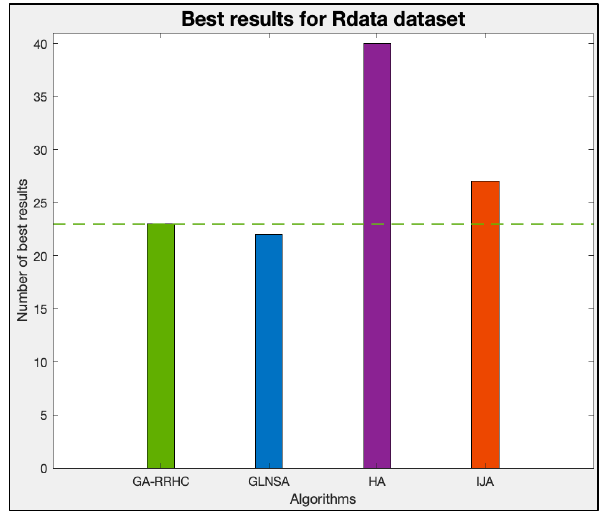
Figure 16. Number of best results per algorithm for the Rdata